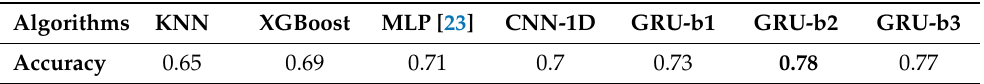
Table 3. Psychological stress state classification accuracy of the proposed algorithm and comparison algorithms on the test set. The number in bold represents the best result. Algorithms KNN